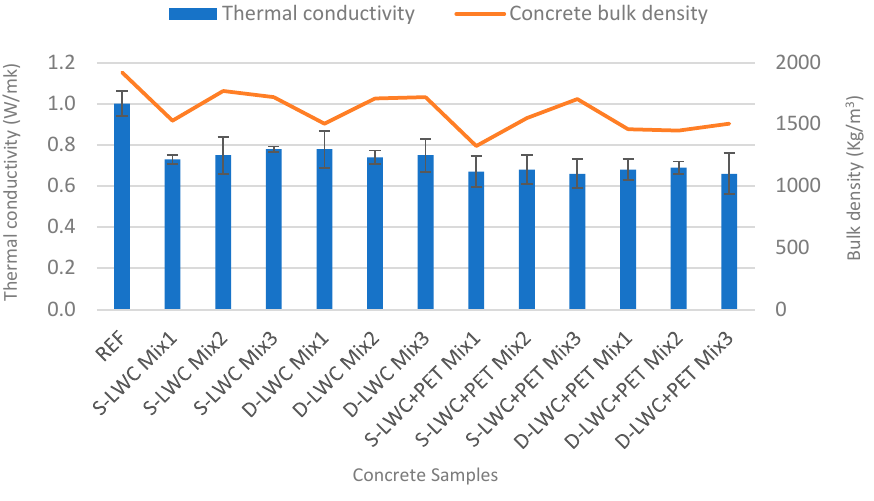
Figure 6. Effect of concrete density on the thermal conductivity.